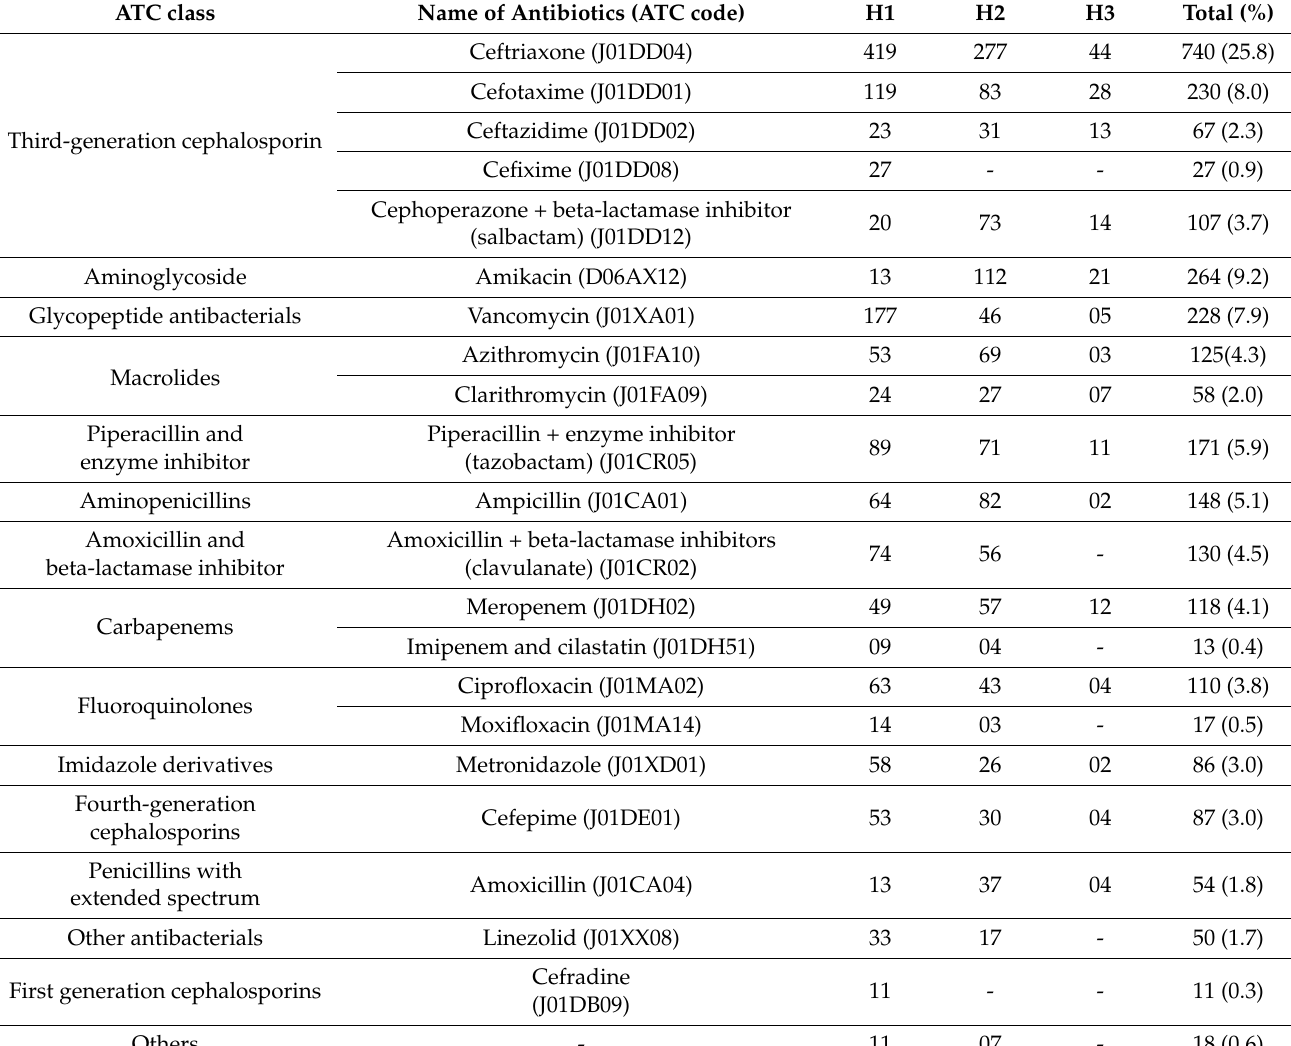
Table 6. Detail of prescribed antibiotics according to ATC classification.